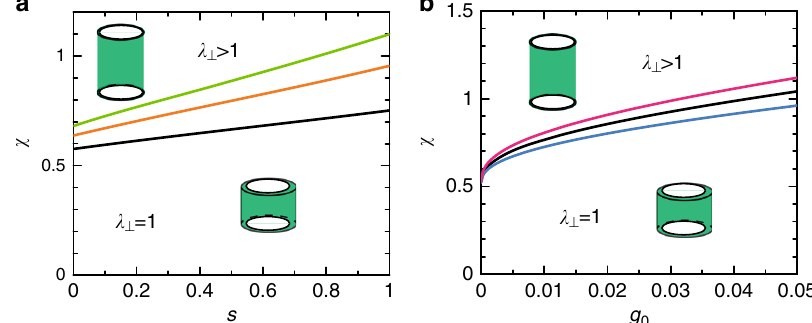
Fig. 4 Phase diagram of the composite gel. a The phase diagrams of a composite gel are shown as functions of the volume ratio s ( ≡ ( r ex − r in )/ r in ) (see Fig. 1 for the de fi nition of r ex and r in ) for g 0 = 1.0 × 10 − 3 (black), 5.0 × 10 − 3 (orange), and 1.0 × 10 − 2 (light green), where g 0 is the rescaled shear modulus (de fi ned by Eq. (9)). b The phase diagram is shown as a function of the rescaled shear modulus g 0 for s = 0.1 (cyan), 0.2 (black), and 0.3 (magenta)